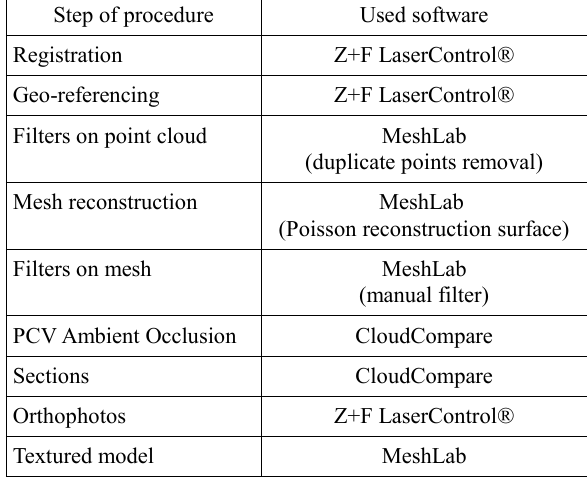
Table 2. Summary of implemented